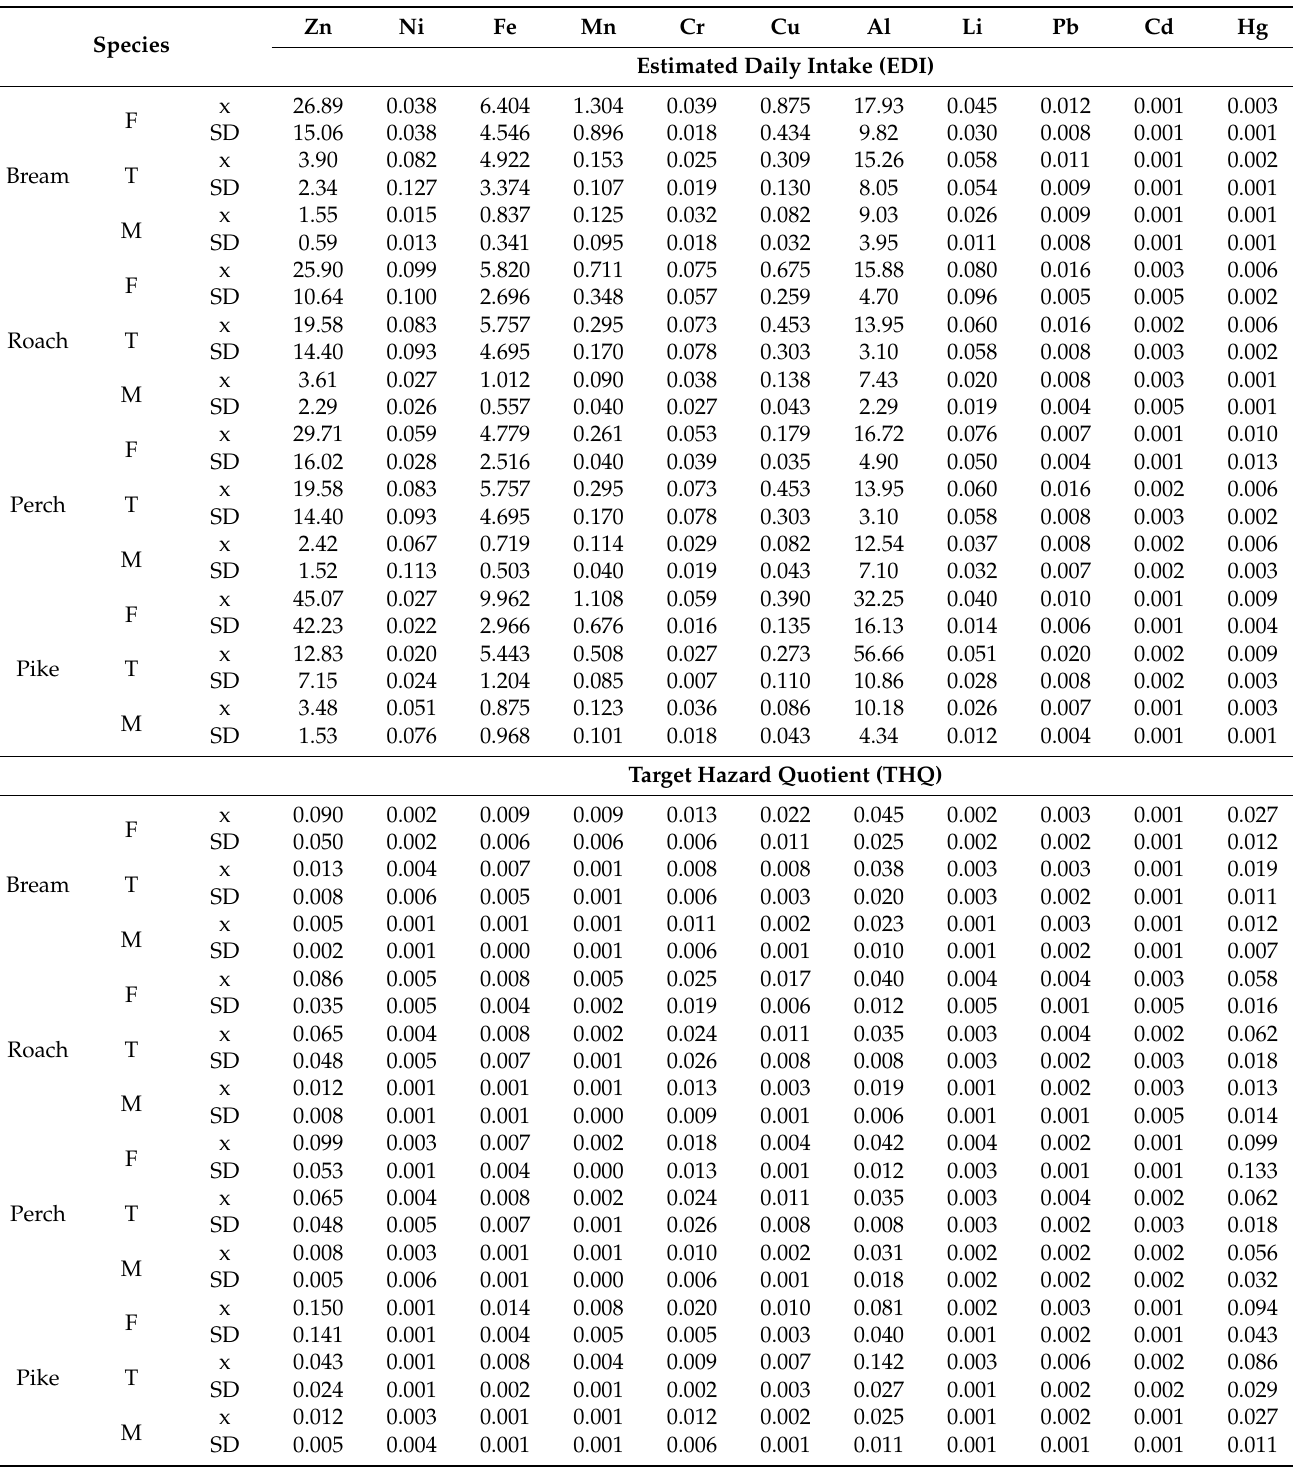
Table 7. Estimated daily intake of elements with a portion of fish (EDI, THQ,